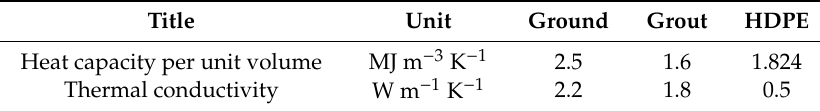
Table 1. Thermophysical properties of solids